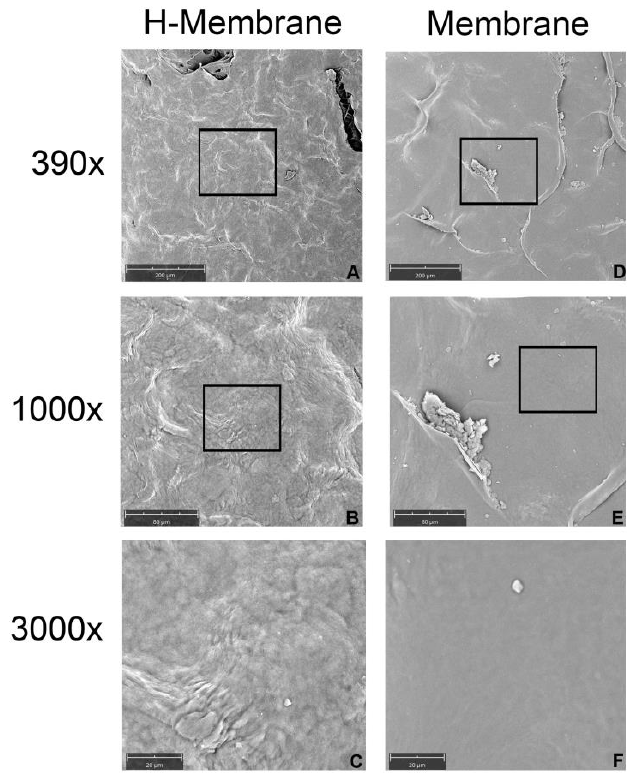
Figure 1. Scanning electron micrograph (SEM) images of the membranes. ( A – C ) hydrated membranes (H-Membrane); ( D , F ) manufactured membrane (Membrane); Mag= 390 × ( A , D ), Magnification = 1000 × ( B , E ), Magnification = 3000 × ( C , F ). The squares indicate the magnified area.